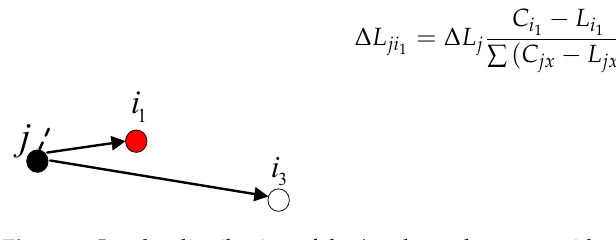
Figure 5. Load redistribution of the j node on the power side.